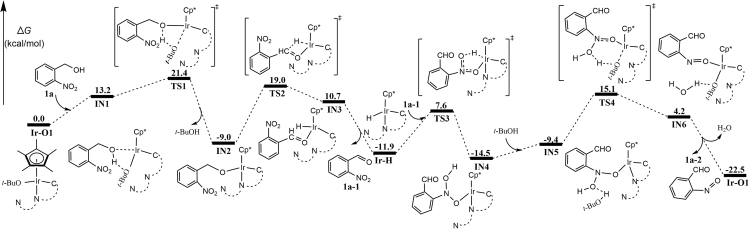
Calculated Energy Profiles for First THo-Nitrobenzene methanol 1a → 2-nitrosobenzaldehyde 1a-2. Values shown are relative free energies in kcal/mol. Also see Tables S3 and S4 and Data S4.